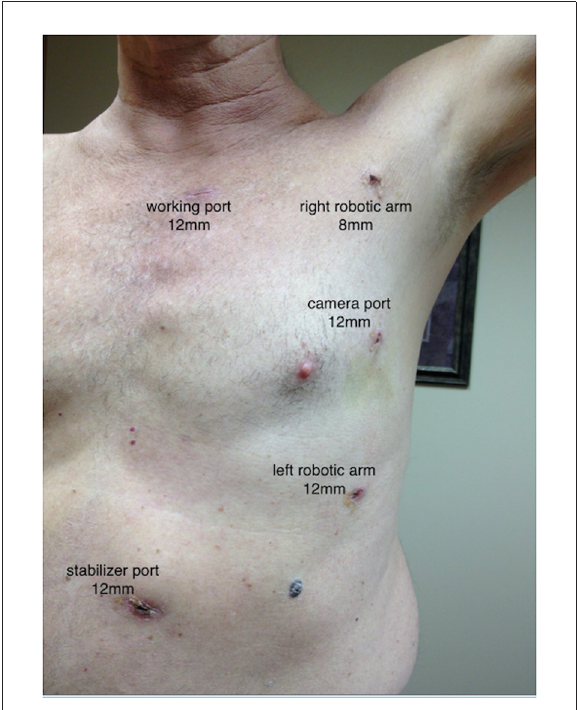
FIGURE1 Illustration of TECAB approach (courtesy of Dr. H.